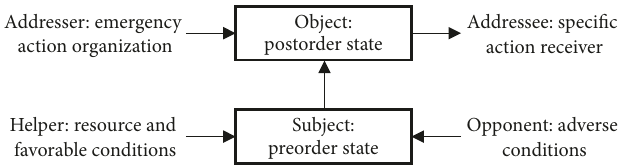
Figure 1: Relationships between actants and explanations in an emergency